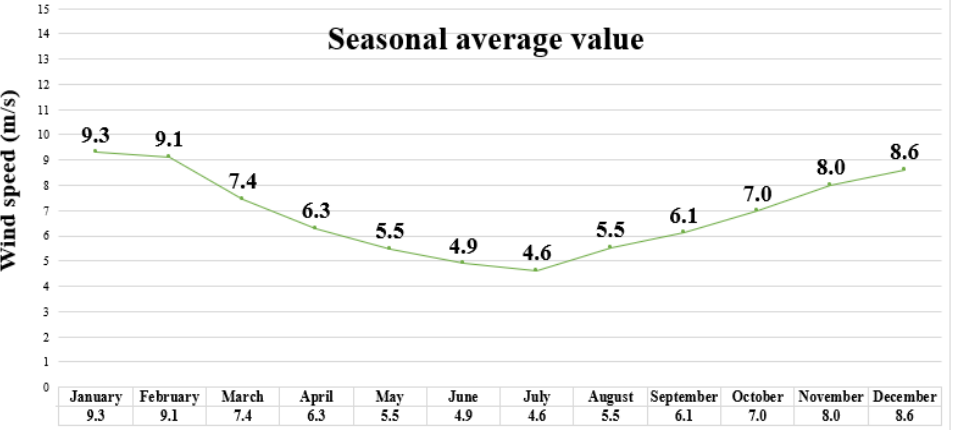
Figure 6. Seasonal average values of the wind speed.